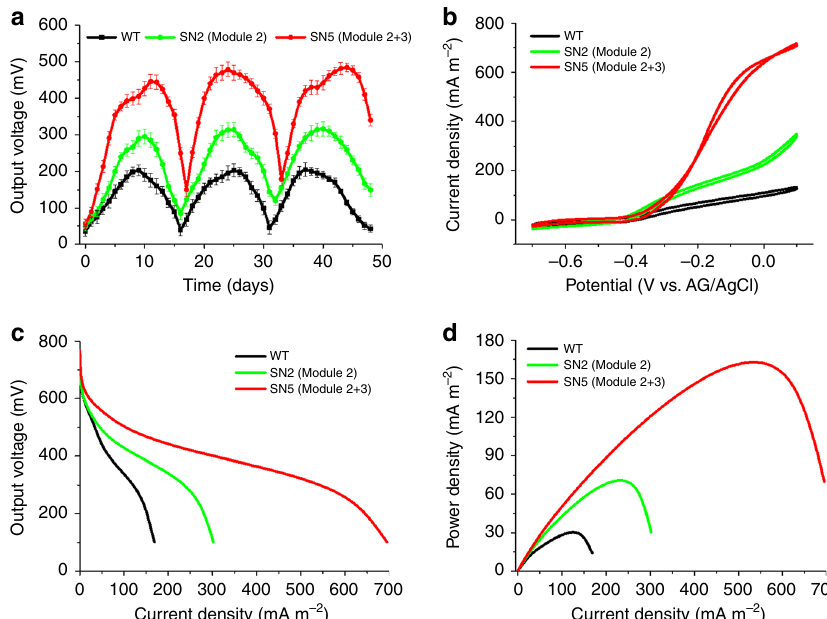
Fig. 6 Bioelectrochemical characterization of the wild-type (WT) and two recombinant S. oneidensis strains (SN2 and SN5). a Multiple-cycle voltage output of the WT S. oneidensis harboring the empty vector (black line), the optimized Module 2 expressing vector (light green line), and the optimized Module 2 and Module 3 expressing vector (red line) simultaneously in MFCs. b Turnover cyclic voltammetry (CV) at a scan rate of 1 mV s − 1 . c Polarization discharge curves obtained by linear sweep voltammetry (LSV) with a scan rate of 0.1 mV s − 1 . The reduced slope of the polarization curve obtained from the recombinant S. oneidensis SN5 was the smallest, indicating less internal resistance. d Power density output curves. SN5 harboring optimized Module 2 and Module 3 obtained a maximum power density of 162.8 ± 5.6 mW m − 2 , which was greater than that of SN2 harboring Module 2 (70.8 ± 6.6 mW m − 2 ) and the WT (30.2 ± 3.4 mW m − 2